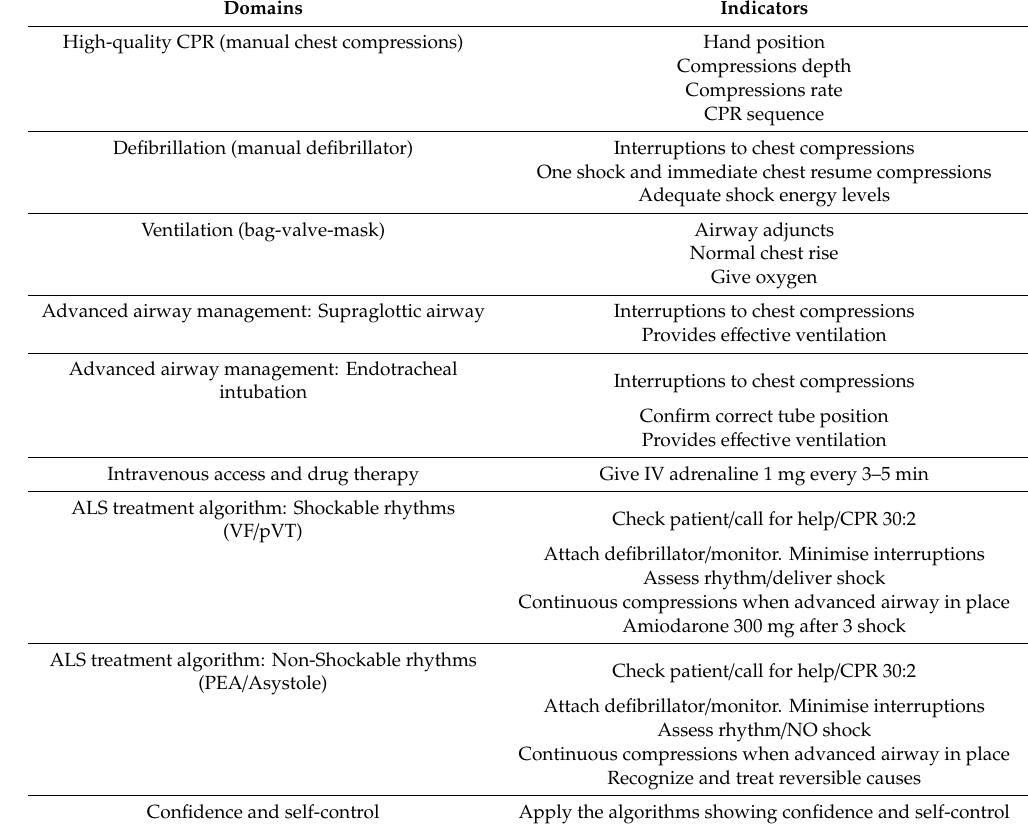
Table 3. Technical skills assessed in post and